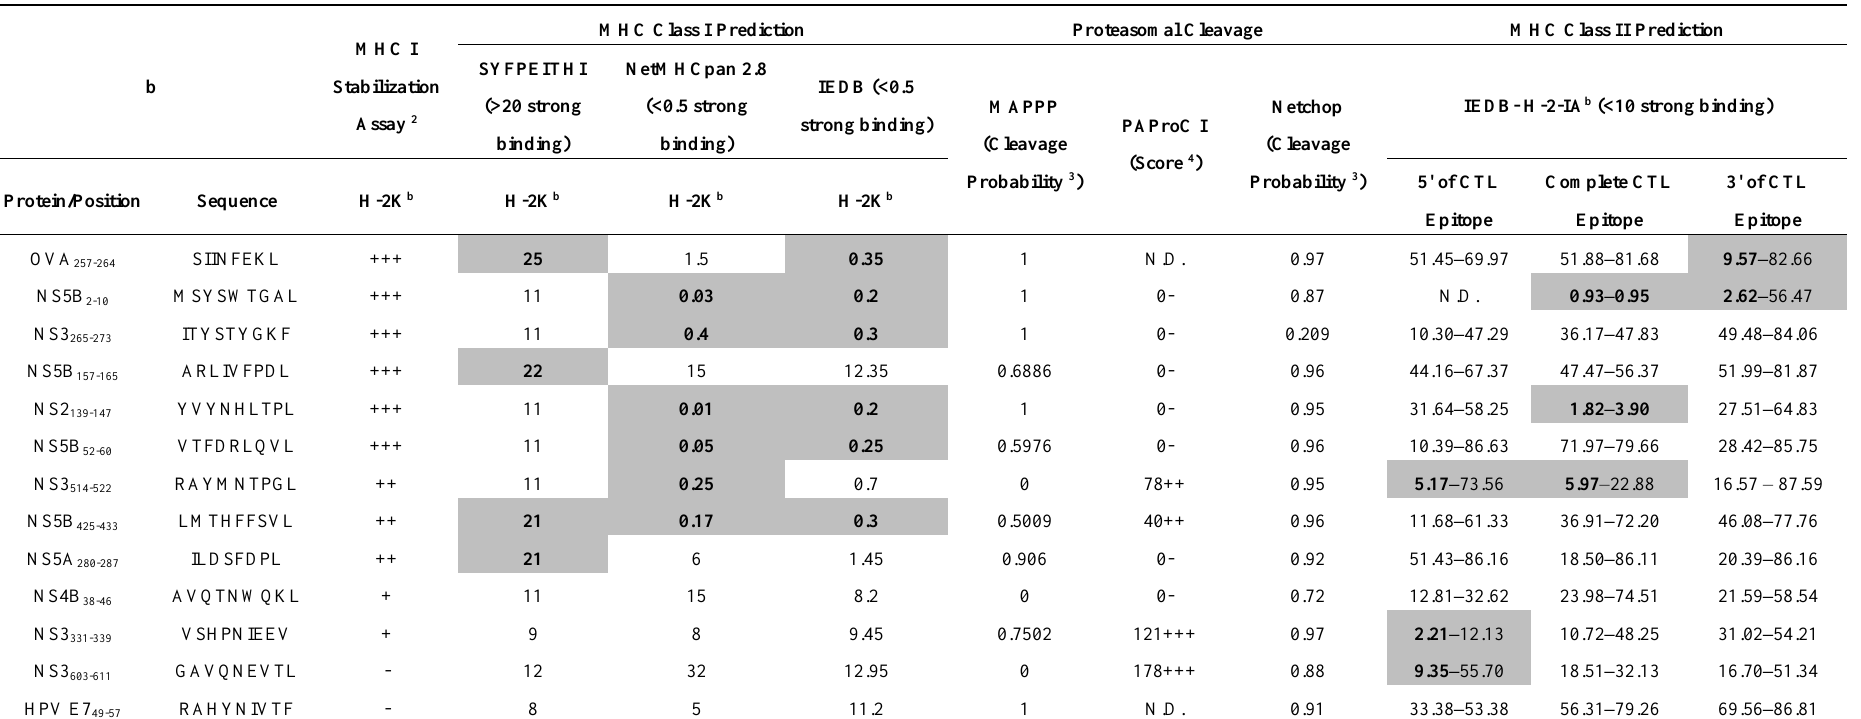
4 PAProC I score: high score indicates high chance for cleavage, also depicted by the number of